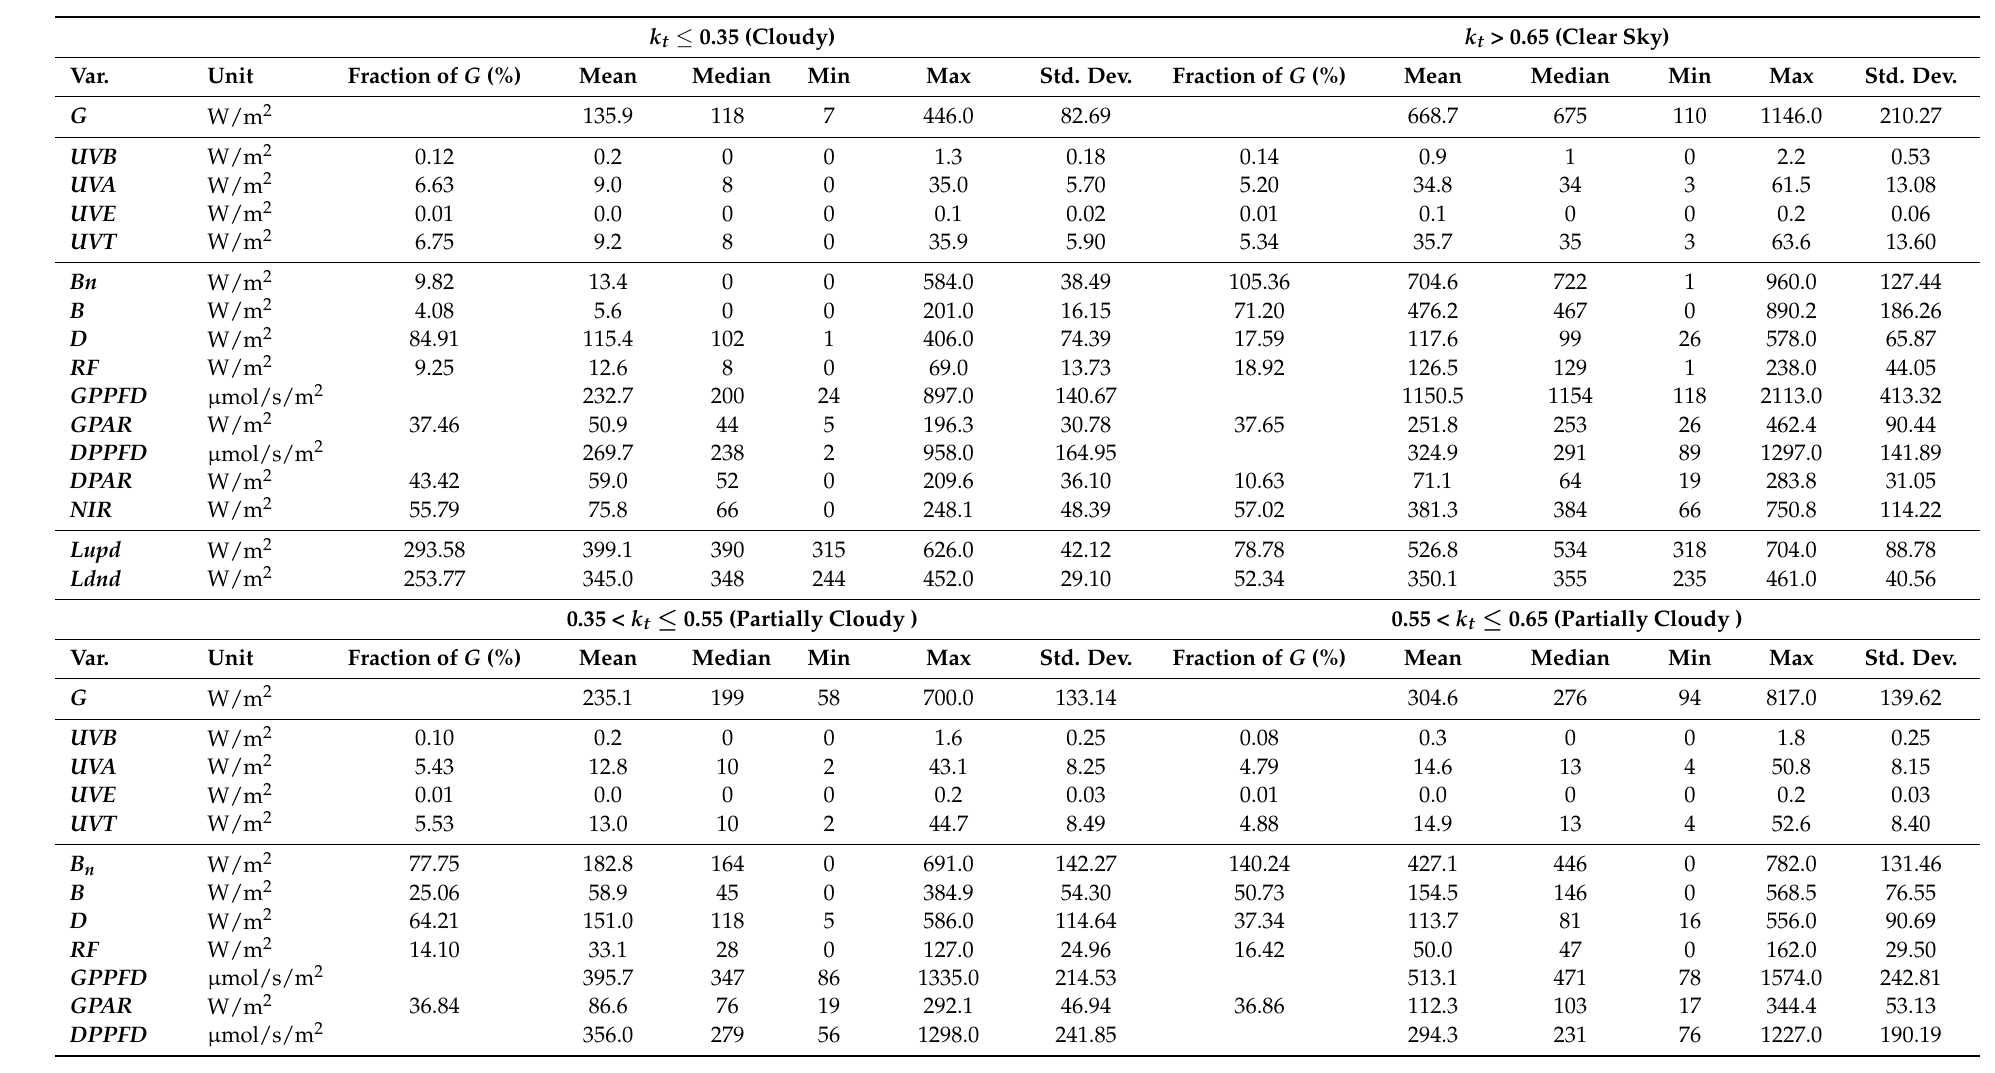
Table 6. Statistical values of all radiation components considering the prevailing weather conditions as classified by the clearness index ( k t ). k t ≤ 0.35